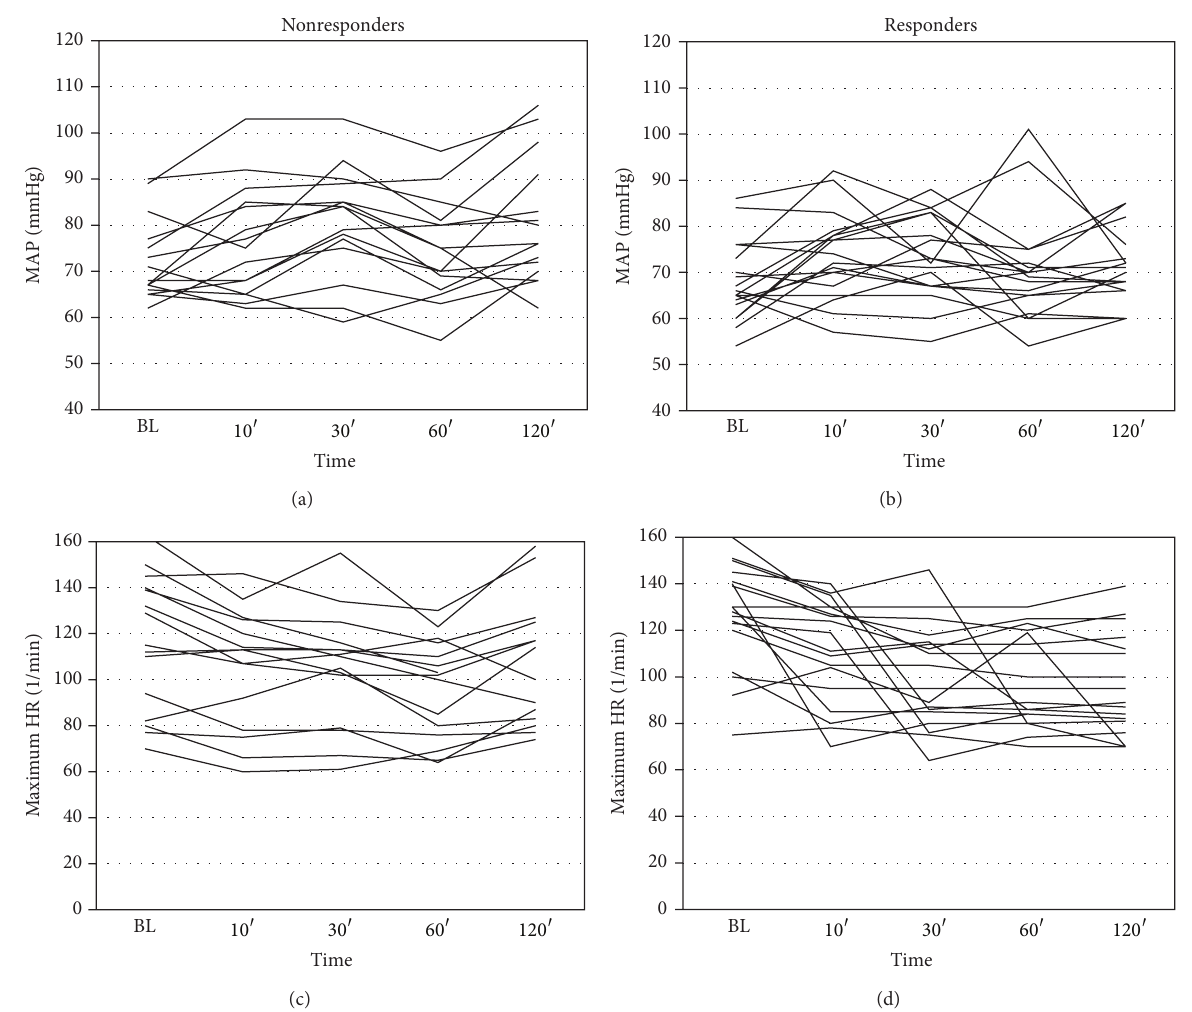
Figure 1: The lines show individual changes of mean arterial pressure (MAP) and heart rate (HR) of nonresponders and responders during the 2 h observation period.